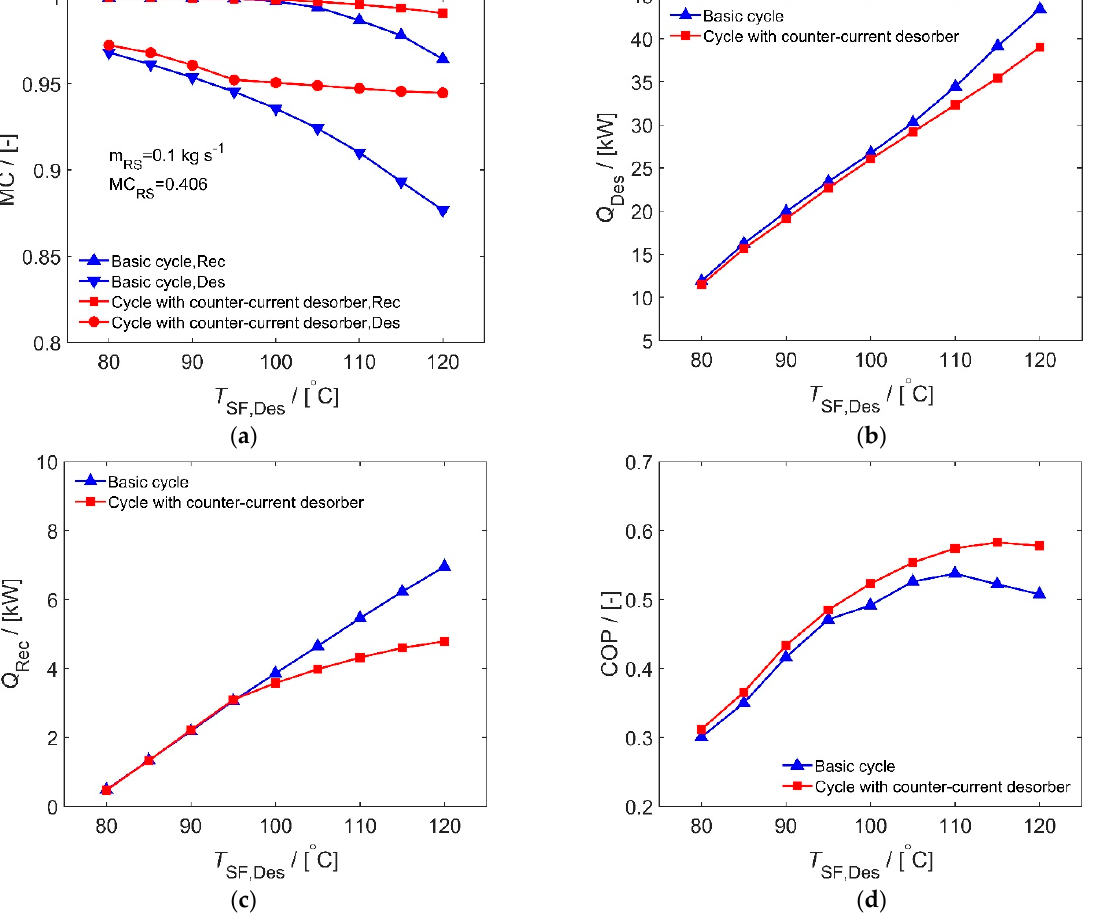
Figure 12. Performances of cycle with counter-current desorber and basic cycle as a function of heat